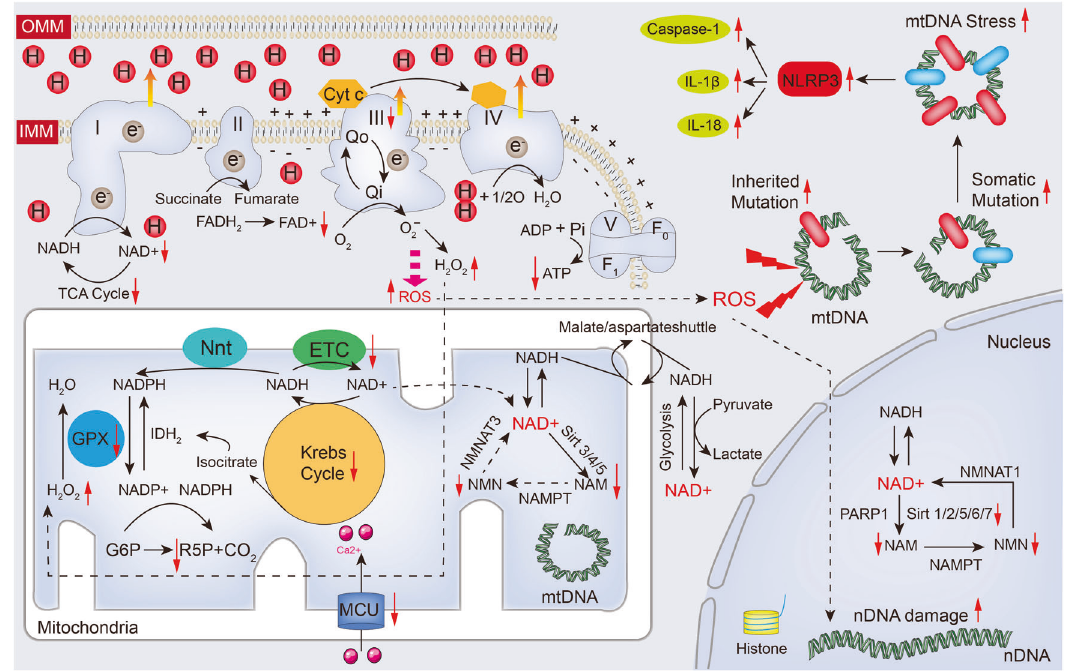
Fig. 4 Altered NAD(H), ROS and mitochondrial DNA during cardiac aging. The electron transport chain (ETC) is a collection of four enzyme complexes (complexes I-IV) and a large protein complex (complex V) responsible for synthesizing ATP in the mitochondrial inner membrane. It generates ATP from ADP, Pi, and Mg2 + using an electrochemical gradient of protons created by the electron transport chain. As electrons pass down the redox potential gradient from NADH or FADH2 to oxygen, hydrogen ions are actively transported from the matrix to the cytosolic side of the inner membrane by complexes I, III, and IV. Complex I oxidizes NADH, which leads to sequential electron fl ow to coenzyme Q, complex III, cytochrome c, and ultimately to cytochrome oxidase (complex IV), where oxygen is reduced to water. However, during cardiac aging, the decline in respiration favors the relative reduction of complexes I and III, leading to increased ROS production. This increased ROS contributes to the impairment of the Krebs cycle and reduced ATP production. Furthermore, the cytoplasmic and nuclear NAD + pools probably equilibrate by diffusion through the nuclear pore. However, the mitochondrial membrane is impermeable to both NAD + and NADH. Reducing equivalents generated by glycolysis are transferred to the mitochondrial matrix via the malate/aspartate shuttle. In addition, different NAD + -consuming enzymes lead to the generation of nicotinamide, which is recycled via the NAD + salvage pathway. Different forms of the NMNAT enzyme and sirtuins are localized in different compartments. Of note, a proportion of ROS is involved in reduction reaction by mitochondrial antioxidant system GPX device. While overburden of ROS leads to mtDNA mutation and damage to promote activation of NLRP3 in fl ammasome. Red arrows indicate alterations that occur in the aging heart (see text for details). ADP adenosine diphosphate, ATP adenosine triphosphate, Cyt c cytochrome c, FAD fl avin adenine dinucleotide, FADH 2 reduced fl avin adenine dinucleotide,